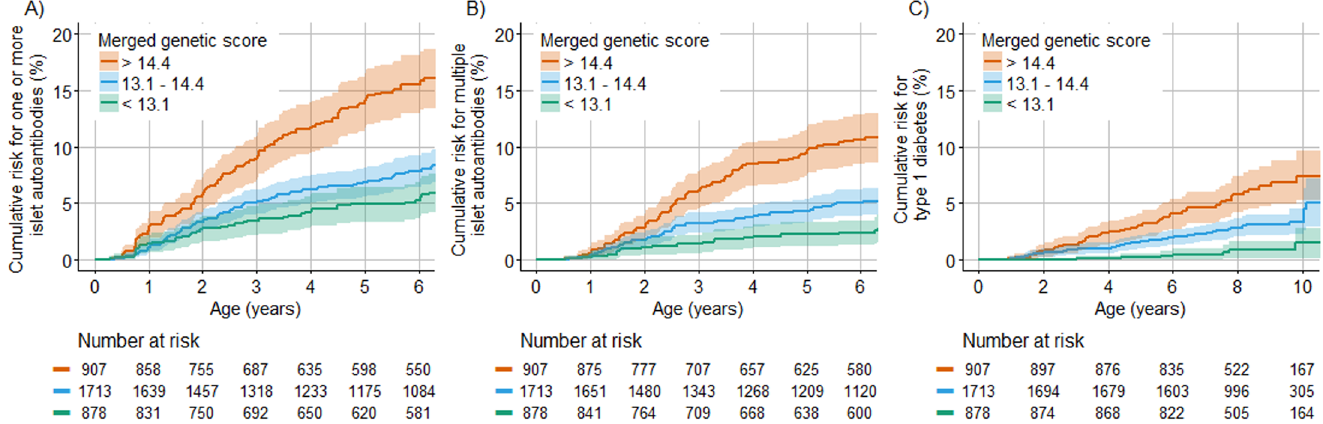
Fig 4. Cumulative risks of 1 or more islet autoantibody, multiple islet autoantibody, and type 1 diabetes development in TEDDY children with the HLA DR3/ DR4-DQ8 or DR4-DQ8/DR4-DQ8 genotype stratified by their merged score. The cumulative risk of developing 1 or more islet autoantibodies (A), multiple islet autoantibodies (B), and type 1 diabetes (C) ( y- axis) is shown relative to age in years ( x- axis) and was calculated using the Kaplan–Meier method. Curves are shown for children with genetic scores in the upper (orange line), lower (green line), and 2 middle (blue line) quartiles. The shaded areas represent the 95% confidence interval of the cumulative risk. The numbers at risk indicate the number of children included in the analysis at each age.